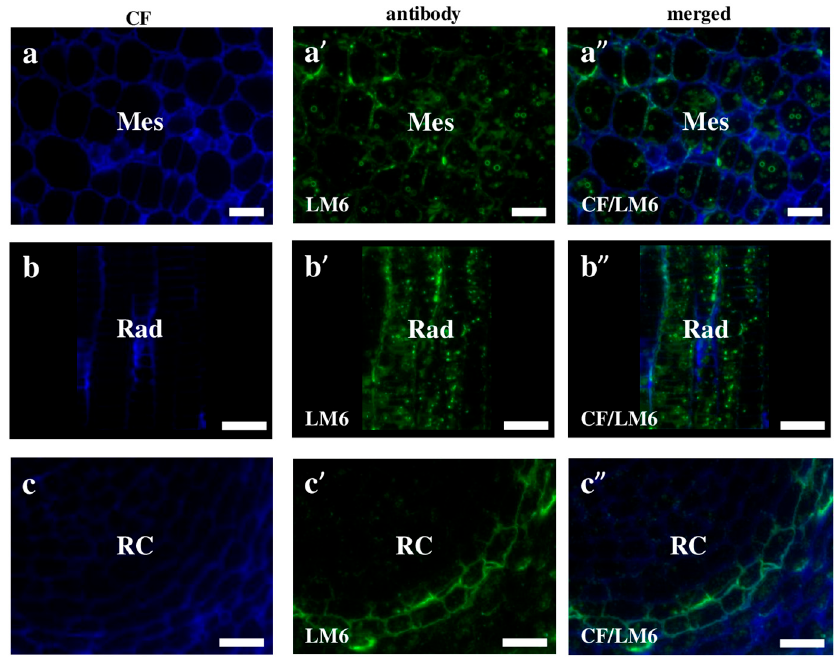
Figure 8. Immunolocalisation of pectins in Brachypodium embryos. ( a – a” ) Mesocotyl; ( b – b” ) radicula and ( c – c” ) root cap. All with LM6. Abbreviations: CF—calcofluor, Rad—radicula, RC — root cap, and Mes—mesocotyl. Bars: ( a – a” , b – b” ) 10 µm; ( c – c” ) 20 µm.